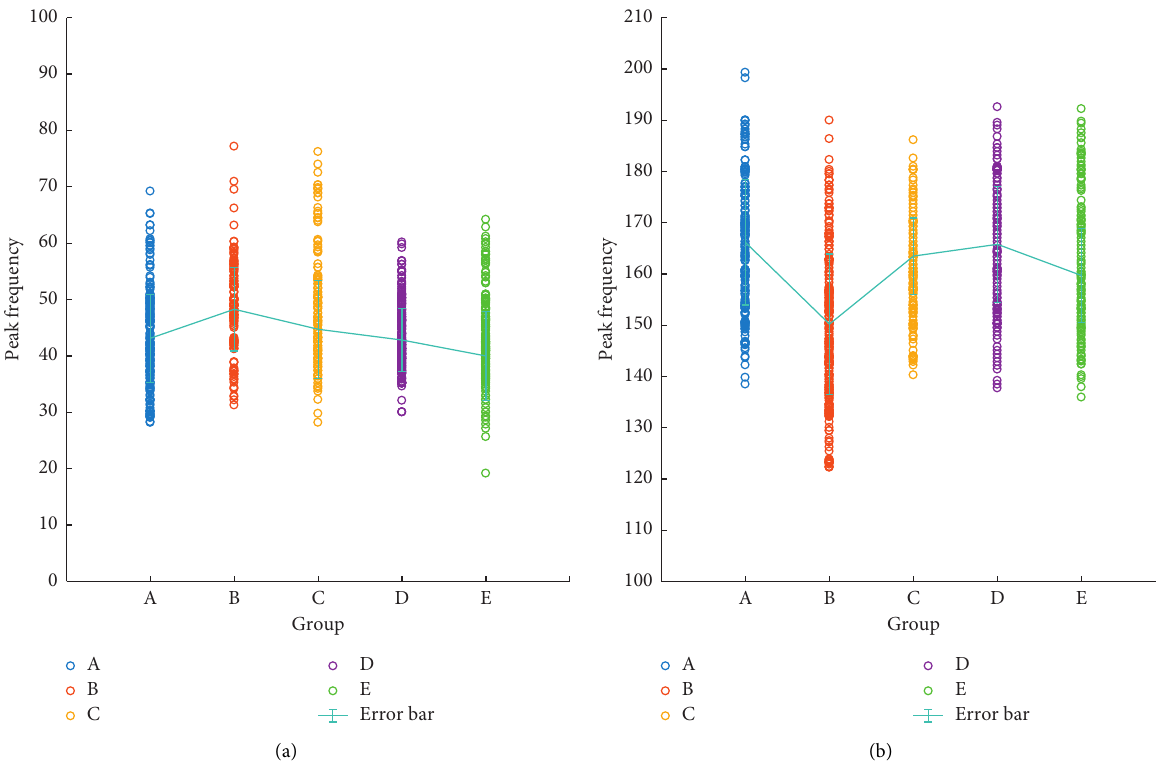
Figure 8: Variation trend of the peak frequency mean value for each group (indicated by the solid cyan line). (a) The low-frequency bands and (b) the high-frequency